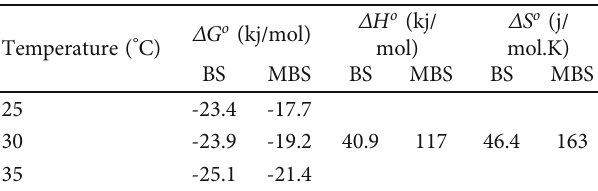
Table 8: Adsorption thermodynamic parameters of Pb (II) on BS and MBS at 100mg/L of initial